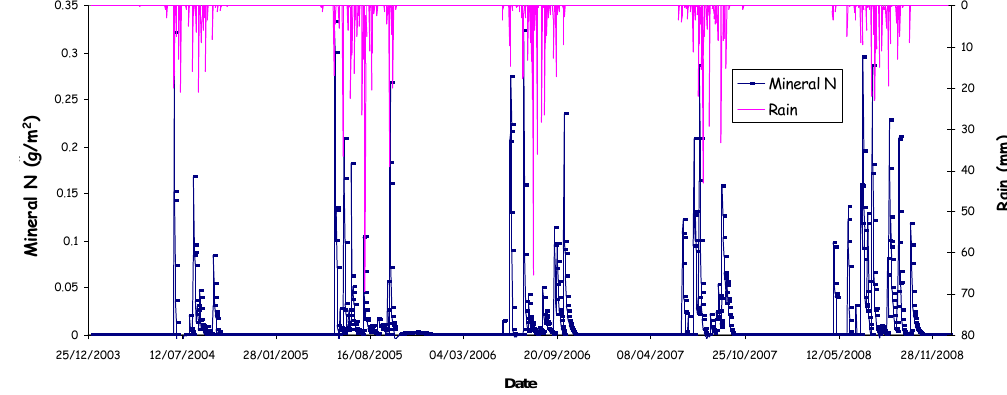
Figure 7. Simulated mineral N in gm − 2 and rain in mm for years 2004 to 2008 at